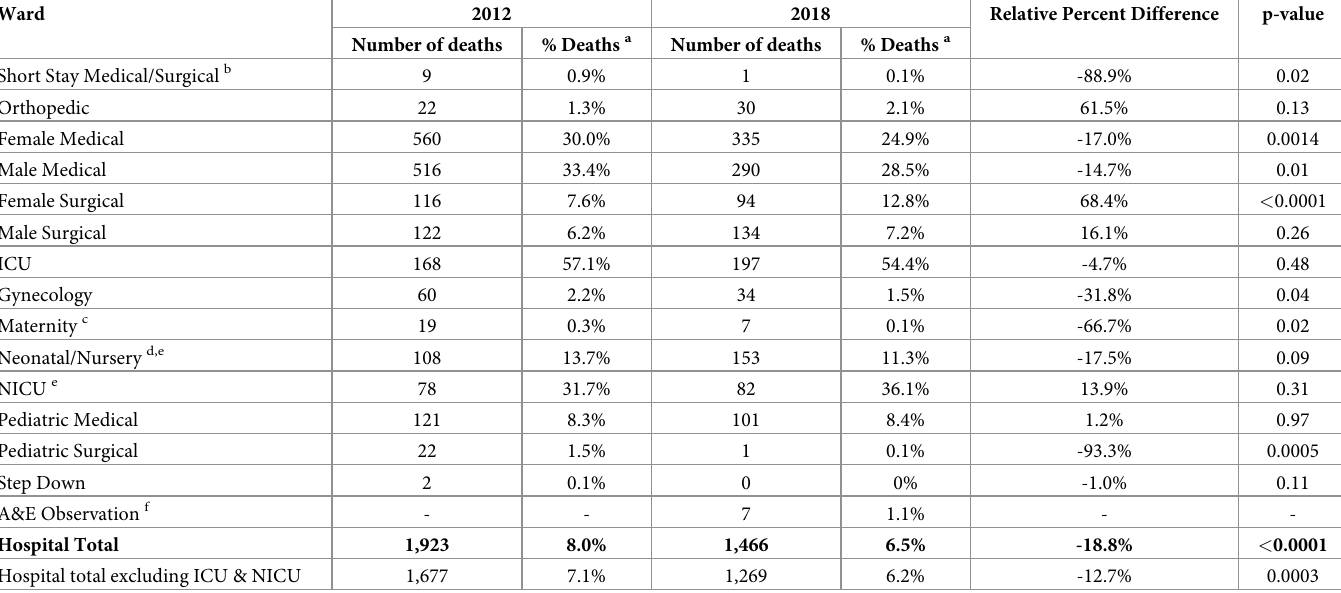
Table 4. Ward-level Patient Deaths at Queen ‘Mamohato Memorial Hospital Integrated Network Managed by a Public-Private Partnership in 2012 and 2018.